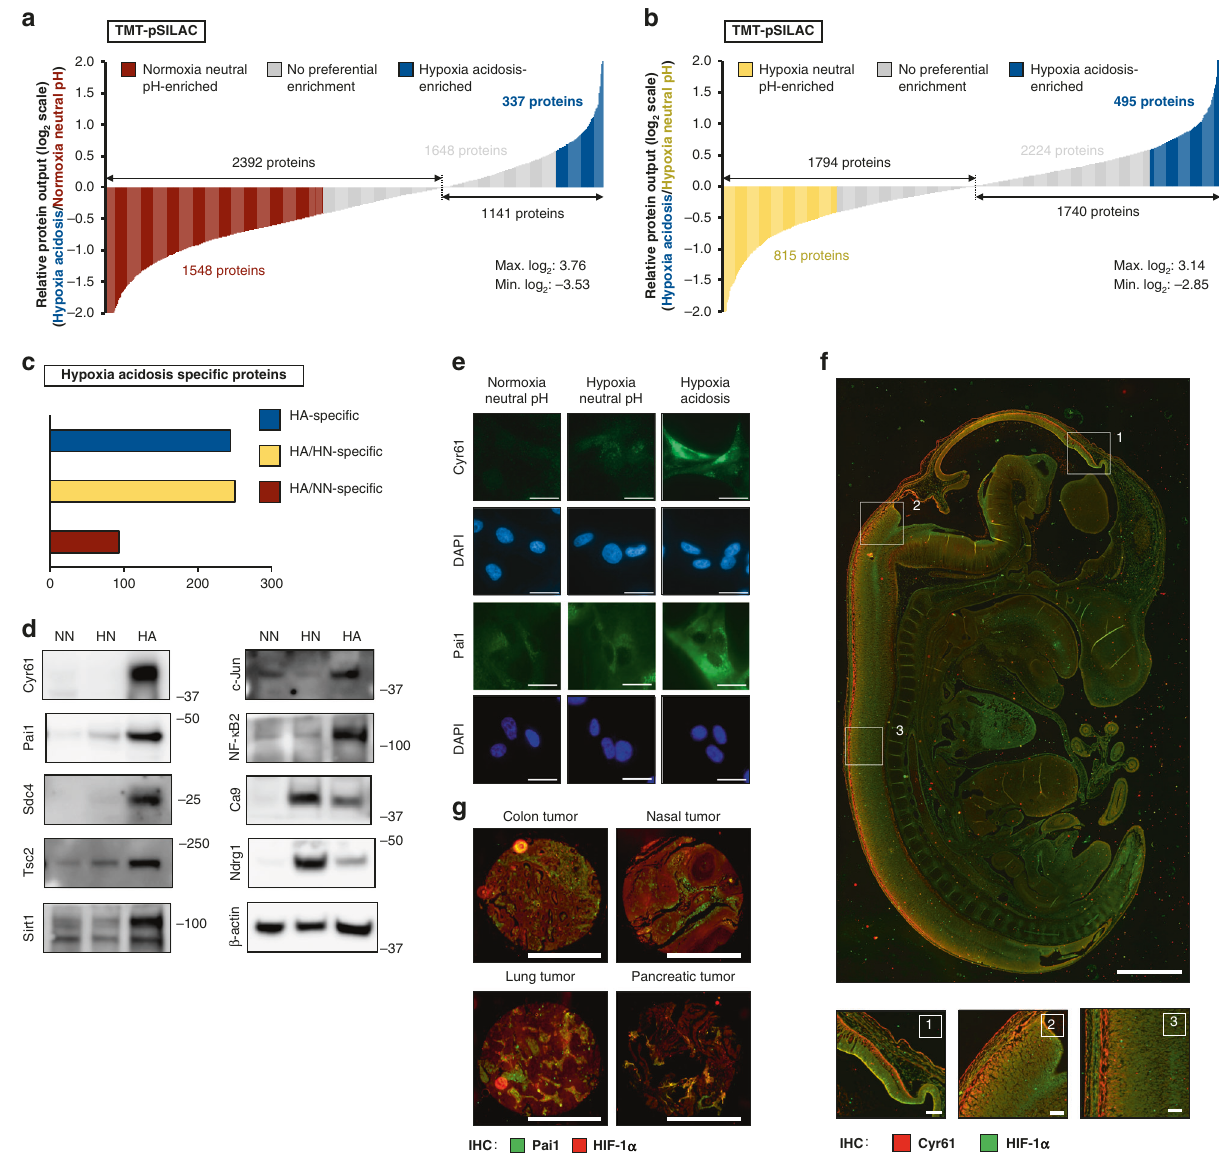
Fig. 3 TMT-pSILAC identi fi es the translatome of anaerobic acidosis-dependent metabolic depression. Proteomic output analysis by TMT-pSILAC followed by mass spectrometry cells subjected to hypoxia acidosis (HA) versus a basal normoxia-neutral pH (NN) and b hypoxia-neutral pH (HN) conditions. HA enrichment: ≥ 1.5× increase; NN/HN enrichment: ≤ 0.75× decrease. c Graph depicting HA-enriched proteins ( ≥ 1.5× increase), blue = proteins that are upregulated in HA compared to both conditions, yellow proteins that are upregulated in HA compared to HN but not NN, red = proteins that are upregulated in HA compared to NN but not HA. Representative d immunoblots and e immunocytochemistry images of hypoxia-acidosis (HA)- speci fi c translatome targets in U87MG. NN normoxia-neutral pH, HN hypoxia-neutral pH, n = 5. Scale bars: 20 μ m. f Representative images of Cyr61 (HA- speci fi c marker, red) and HIF-1 α (classic hypoxia marker, green) immunohistochemistry in embryonic day 12 (ED12) CD1 mouse embryo. Scale bars: 1000 μ m. Enlarged images of indicated sections (top) are presented on bottom panels ( n = 3). Scale bars: 100 μ m. g Representative images of Pai1 (HA- speci fi c marker, green) and HIF-1 α (hypoxia marker, red) immunohistochemistry in human hypoxic tumor core sections ( n = 3). Scale bars: 1000 μ